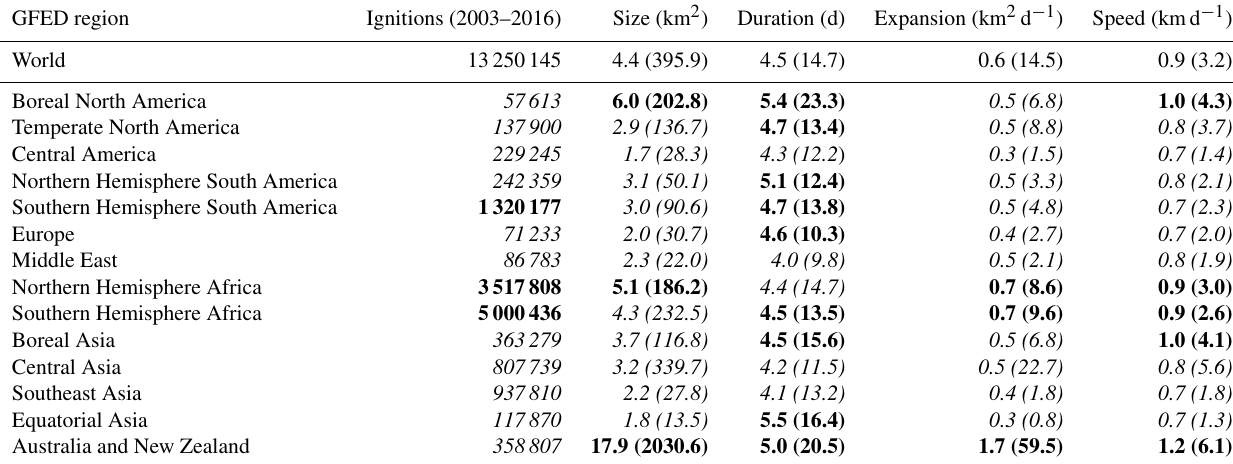
Table 1. Fire attributes for each Global Fire Emissions Database (GFED) region during 2003–2016. Ignitions are the summed ignitions over the study period (2003–2016). For size, duration, expansion and speed we report the mean values for individual fires and also the mean weighted by fire size (the latter estimate is provided in parentheses). For ignitions, regions with over a million ignitions are shown in bold font and lower values in italic font. For other fire aspects, values equal to or above the global average are shown in bold font and below the global average in italic font. A map of the GFED regions is shown in Appendix B (Fig.